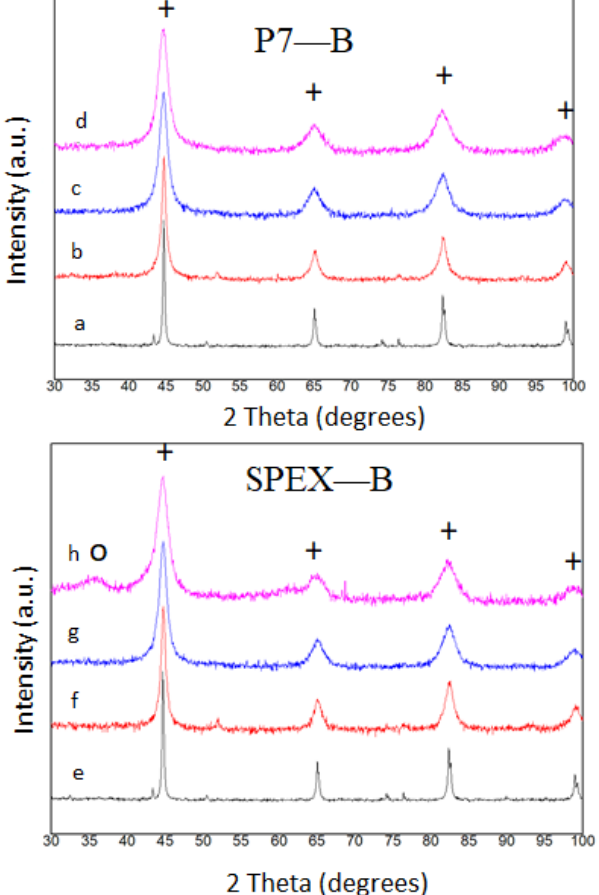
Figure 2. XRD diffraction patterns of alloy B (Fe 80 (NiZr) 7 B 12 Cu 1 ). In the P7: ( a ) Before milling (0 h) and after milling (( b ) 5 h, ( c ) 20 h, ( d ) 80 h); or in the Spex mill: ( e ) Before milling (0 h) and after milling (( f ) 5 h, ( g ) 20 h, ( h ) 80 h). Bcc Fe rich solid solution (+), disordered phase (O).